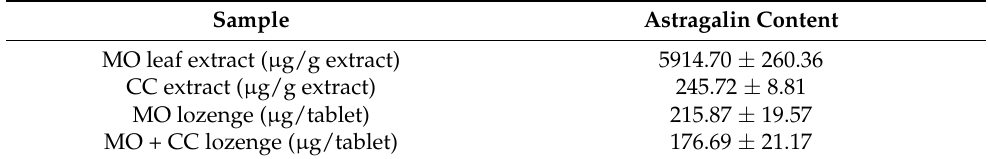
Figure 1. HPLC system for determination of astragalin at 267 nm. Typical HPLC chromatograms of ( a ) astragalin standard at 20 µg/mL, ( b ) MO leaf extract (3 mg/mL), ( c ) MO lozenges, ( d ) MO + CC lozenges, ( e , f ) astragalin standard and CC extract (3 mg/mL), respectively. Table 2. Concentration of astragalin in sample. The values are the mean ± SD ( n = 3). MO: Moringa oleifera ; CC: Cyanthillium cinereum (Less.) H.